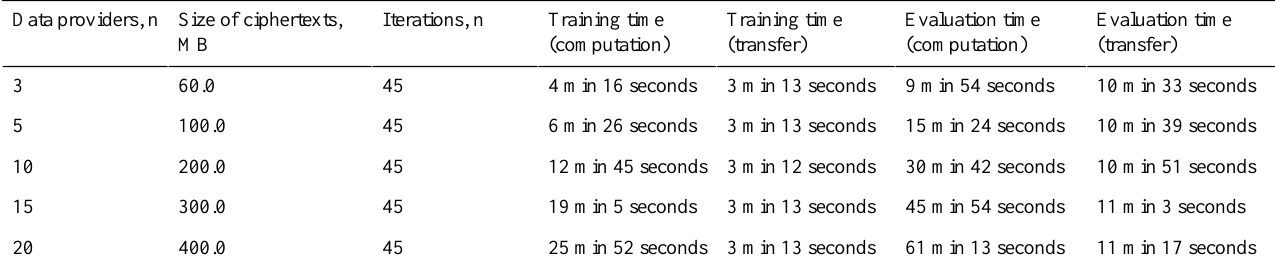
Table 6. Scalability of the proposed protocol for different numbers of data providers (9